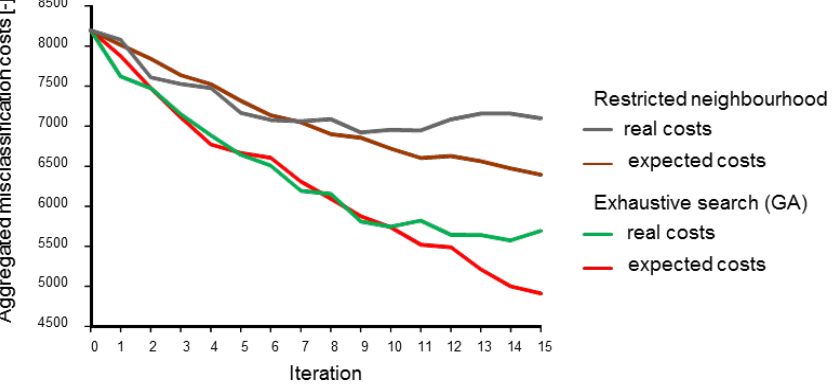
Figure 4. Effect of the way sensor constraints are taken into account on aggregated misclassification costs with two simultaneously moving sensors (scenarios 2 and 3).